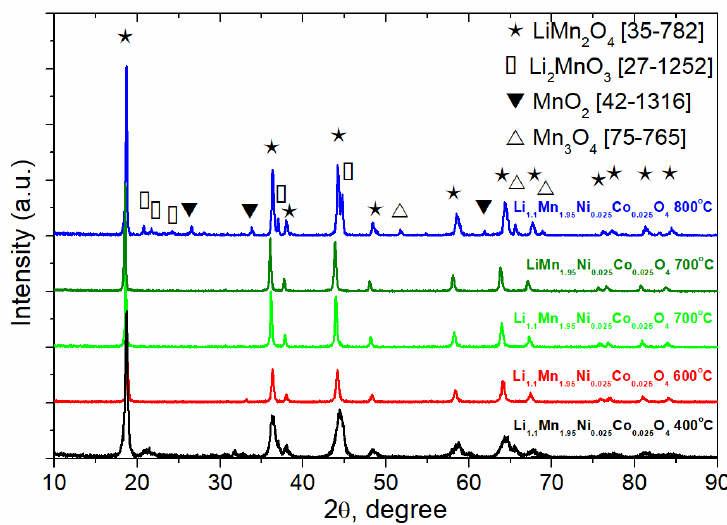
Figure 2. XRD patterns of Li 1.1 Mn 1.95 Co 0.025 Ni 0.025 O 4 samples obtained at different annealing